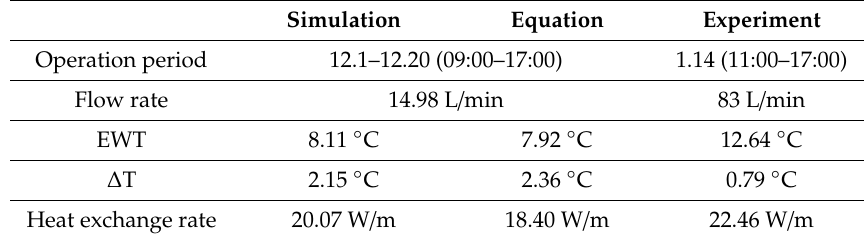
Table 8. Comparison of simulation, equation, and experiment